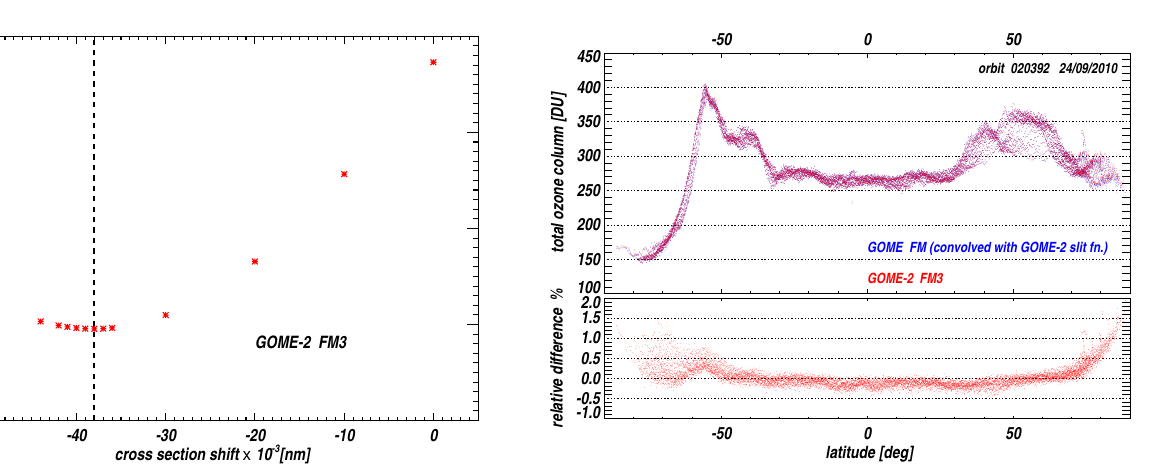
Fig. 8. GOME-2 total ozone column retrievals with different cross section data for orbit 020392 (top panel) and differences between them in percent (bottom